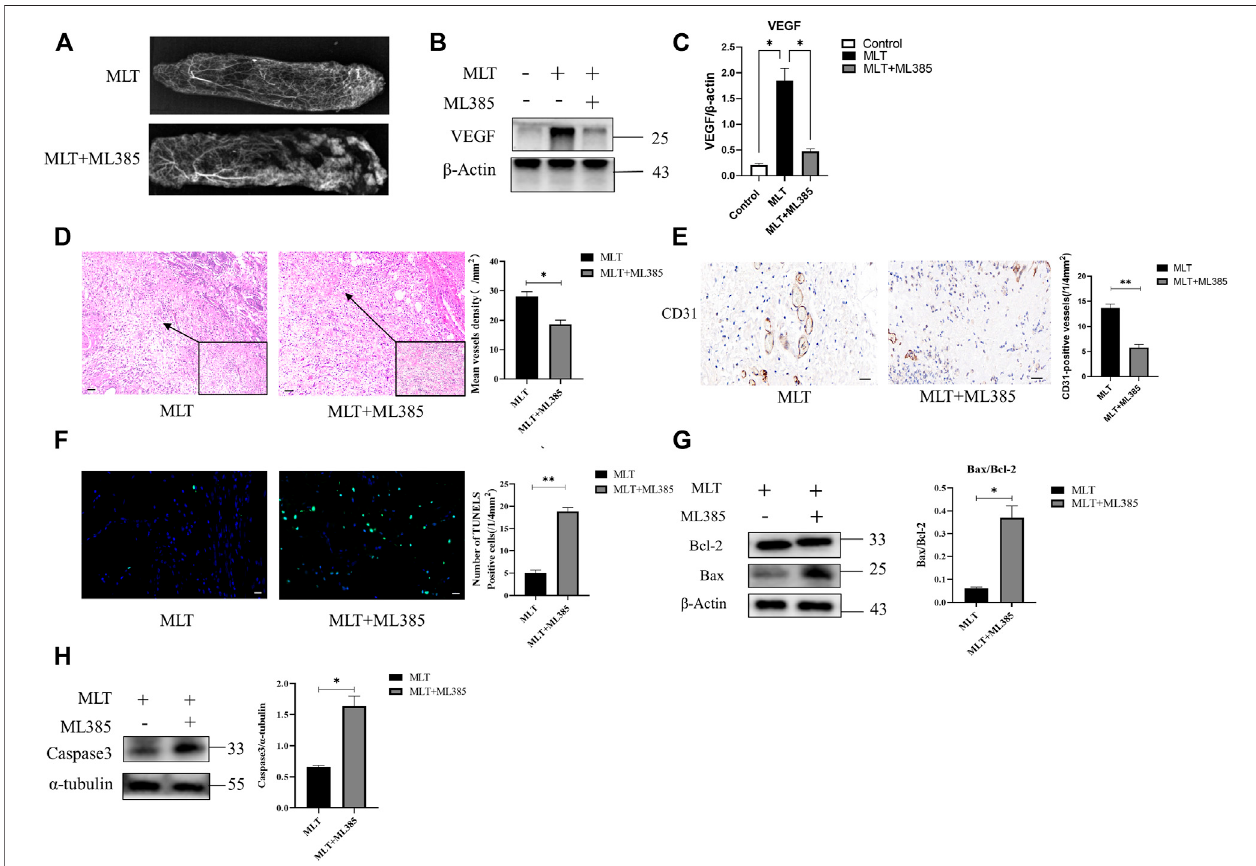
FIGURE 6 | MLT promoted angiogenesis and inhibited apoptosis in fl aps by stimulating NRF2. (A) Angiography showed obvious angiogenesis in the vascular territory of areas I-III. (B) Expression level of VEGF protein. (C) Expression of VEGF mRNA. * p < 0.05 versus the MLT group. (D) Tissue sections after H&E staining and relative quanti fi cation of MVD. Differences between groups are expressed as * p < 0.05. Scale bar: 50 μ m (E) Expression of CD31 by immunohistochemistry. Values are the mean ± SEM, n = 6 per group. Signi fi cant differences between the groups are indicated by** p < 0.001. Scale bar: 20 μ m (F) Immuno fl uorescence detection of apoptoticcellsandTUNELcellsintwogroups;Columnmean±SEM, n =6,comparedwithMLTgroup** p < 0.001.Scalebar:20 μ m (G) Theexpressionandquantitative analysis ofthe apoptosis-related proteins Bax and Bcl-2 by Western blotting. Columns represent the mean ± SEM, * p < 0.05 versus the MLT group. (H) The expression and quantitative analysis of caspase3 and α -tubulin proteins by Western blotting. Columns represent the mean ± SEM, * p < 0.05 versus the MLT group.Abbreviations: MLT, melatonin; MVD, mean vessel density.